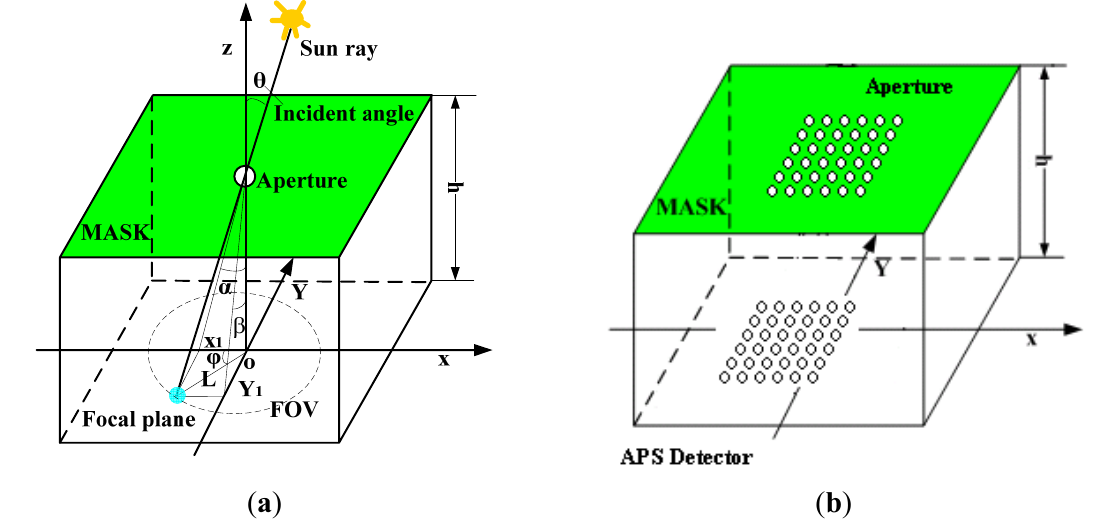
Figure 1. The principle of DSS. ( a ) Single aperture sun sensor; ( b ) Multiaperture sun